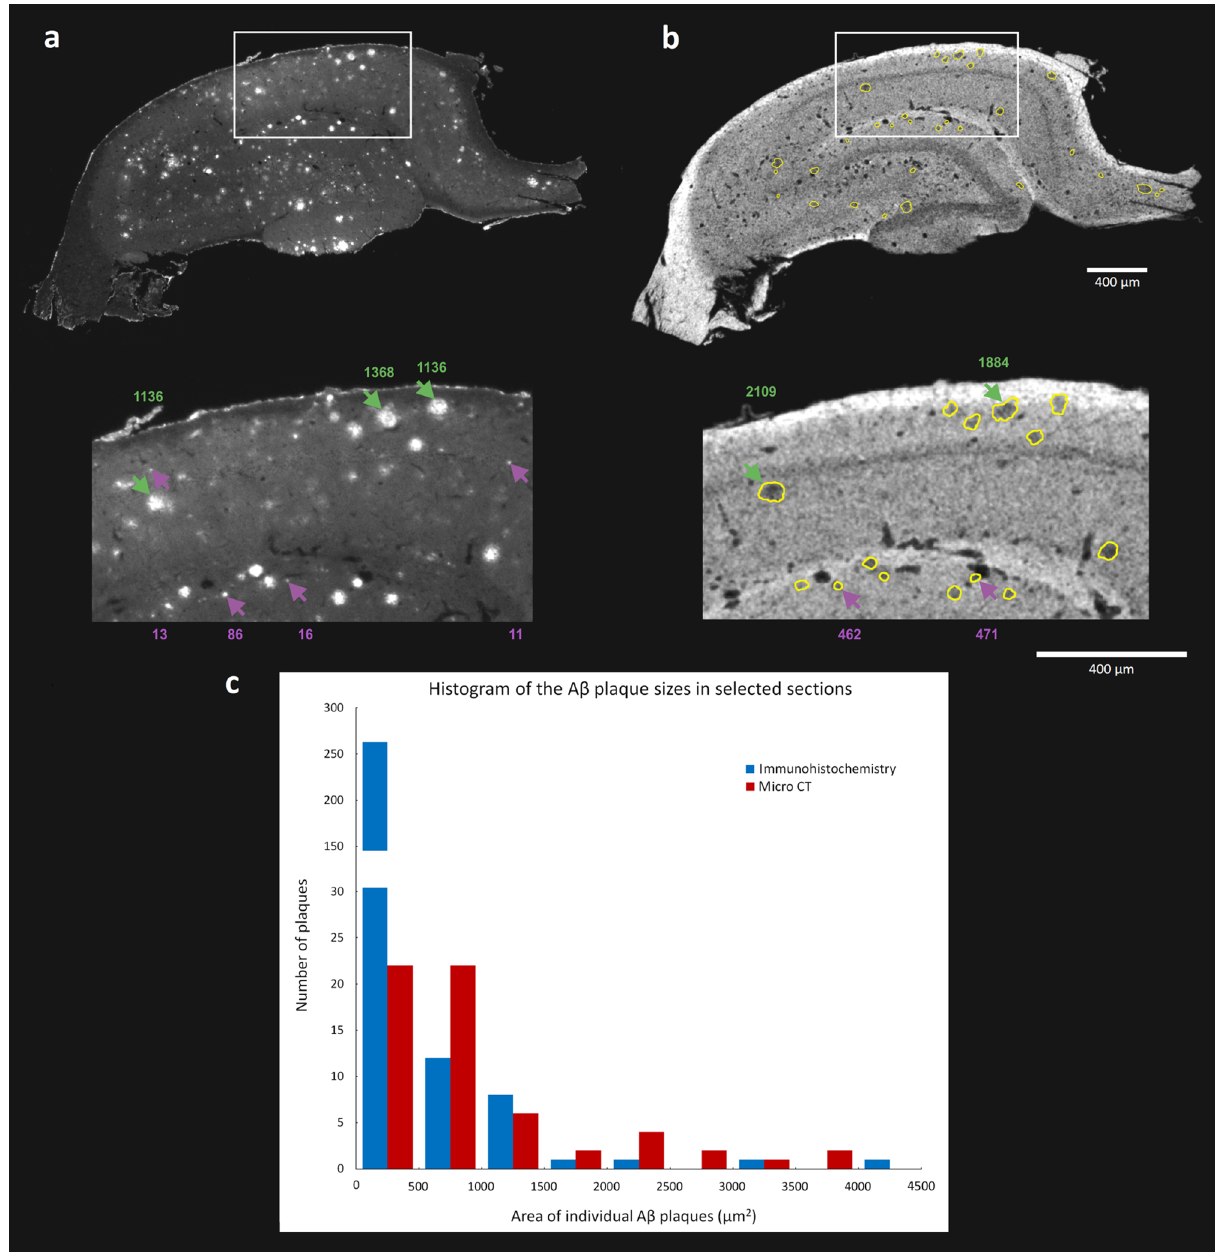
Figure 3. Comparison of the precision in identification of plaques in micro CT data versus the immunohistological detection: Comparison of corresponding sections from the same rat brain showing immunodetected Aβ plaques ( a ) and the micro CT data where the yellow line represents the manually selected plaque boundaries ( b ). The purple arrows indicate examples of the plaque cross sections corresponding to the smallest fraction (0–500 µm 2 ) while the green arrows mark the larger size cases. The corresponding area values in µm 2 are reported in proper colors above and under both pictures. The histogram ( c ) depicts the size interval distribution of detected Aβ plaque sections in the selected slices using immunohistochemistry and micro CT imaging, respectively 41–43